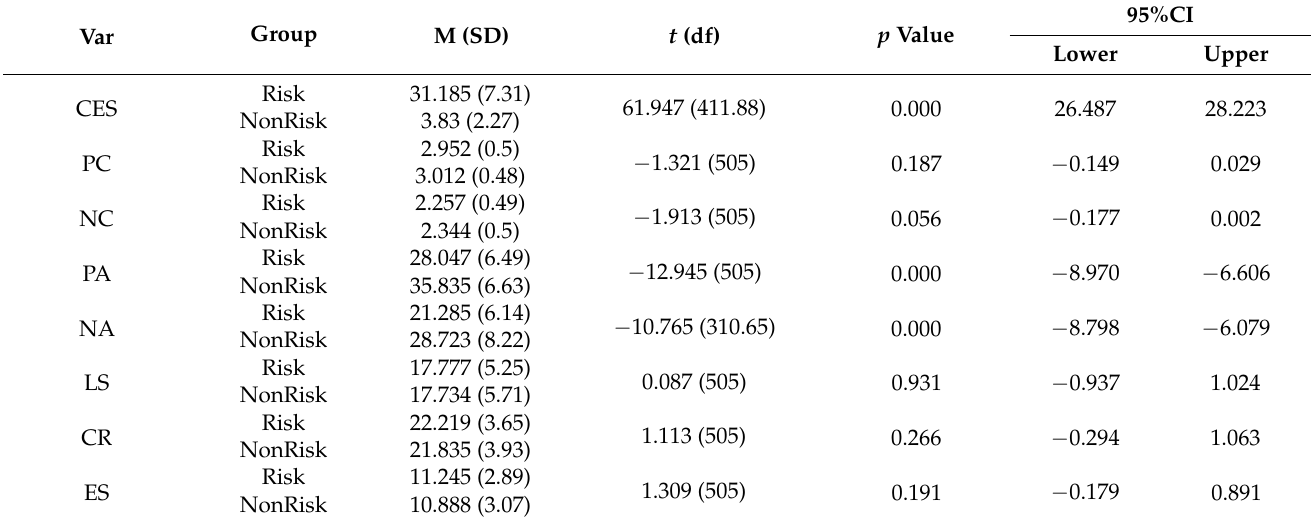
Table 4. Independent samples t -test between risk group and nonrisk